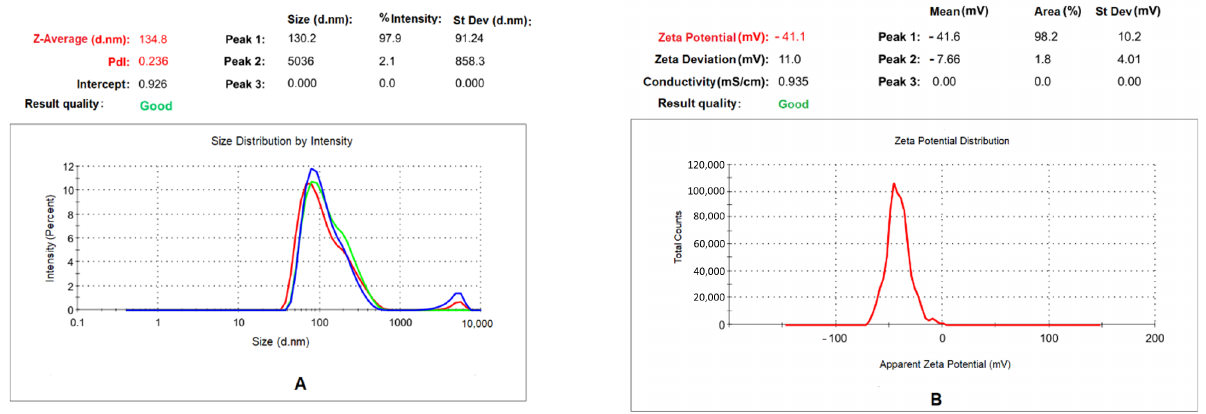
Figure 2. Nanoparticle size measurements: ( A ) size and PDI (red, green, and blue traces correspond- ing to individual measurements); ( B ) ζ-potential of the OSM-AgNPs.